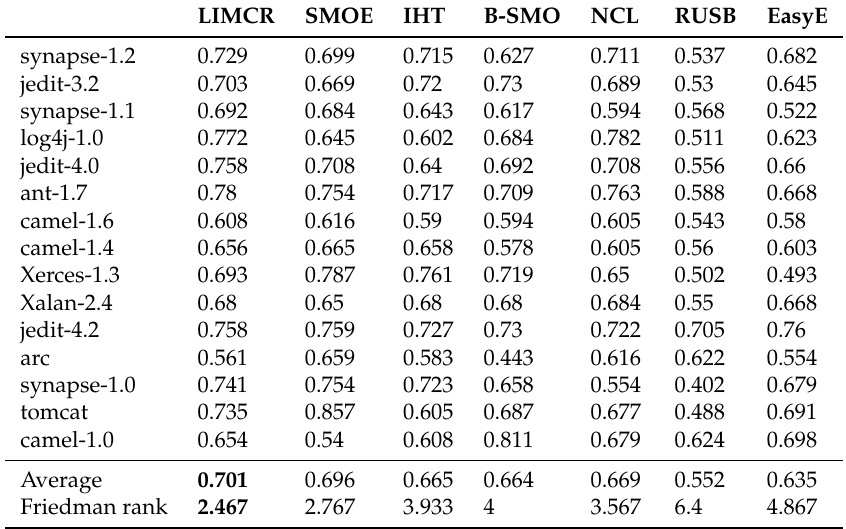
Table 8. Balancedscore of GNB with different imbalance learning methods on small